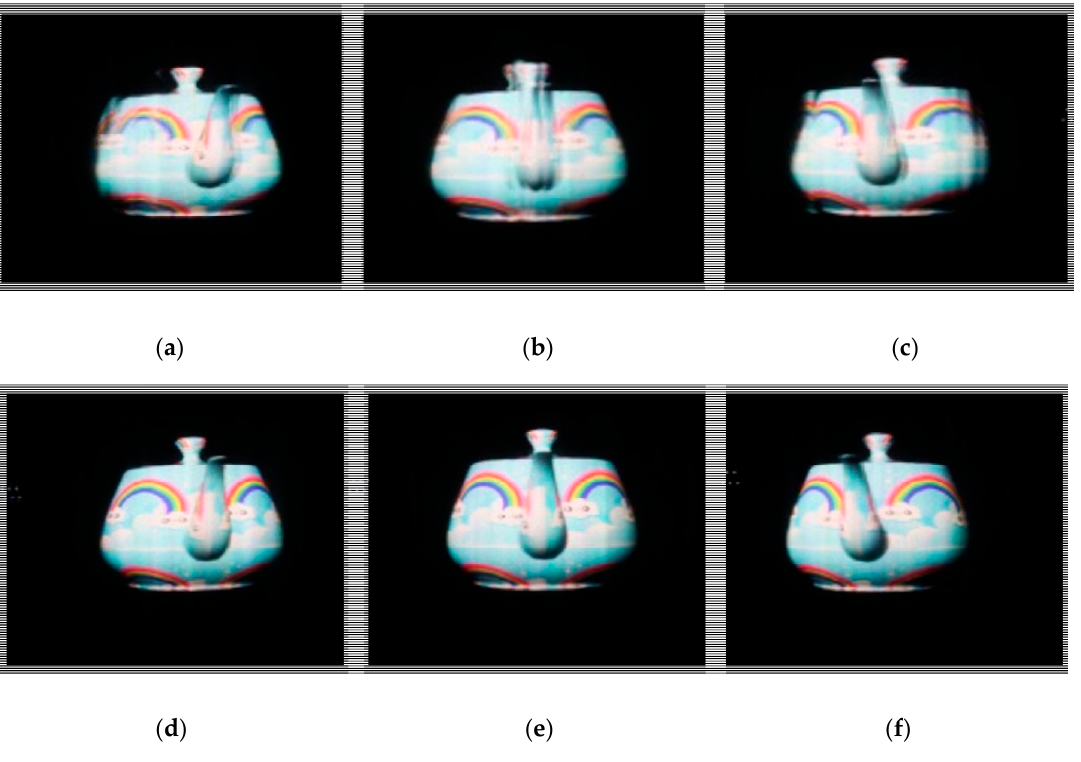
Figure 9. Light-field reconstruction effect under different viewing angles. SPOC algorithm: ( a ) left 30° view, ( b ) middle view, ( c ) right 30° view. Target pixel matching algorithm: ( d ) left 30° view, ( e ) middle view, ( f ) right 30° view.